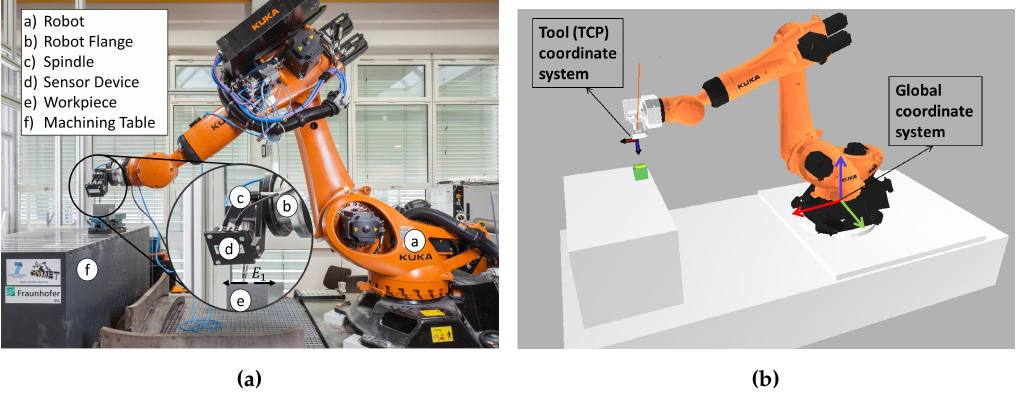
Figure 4. ( a ) Real and ( b ) simulated robot machining